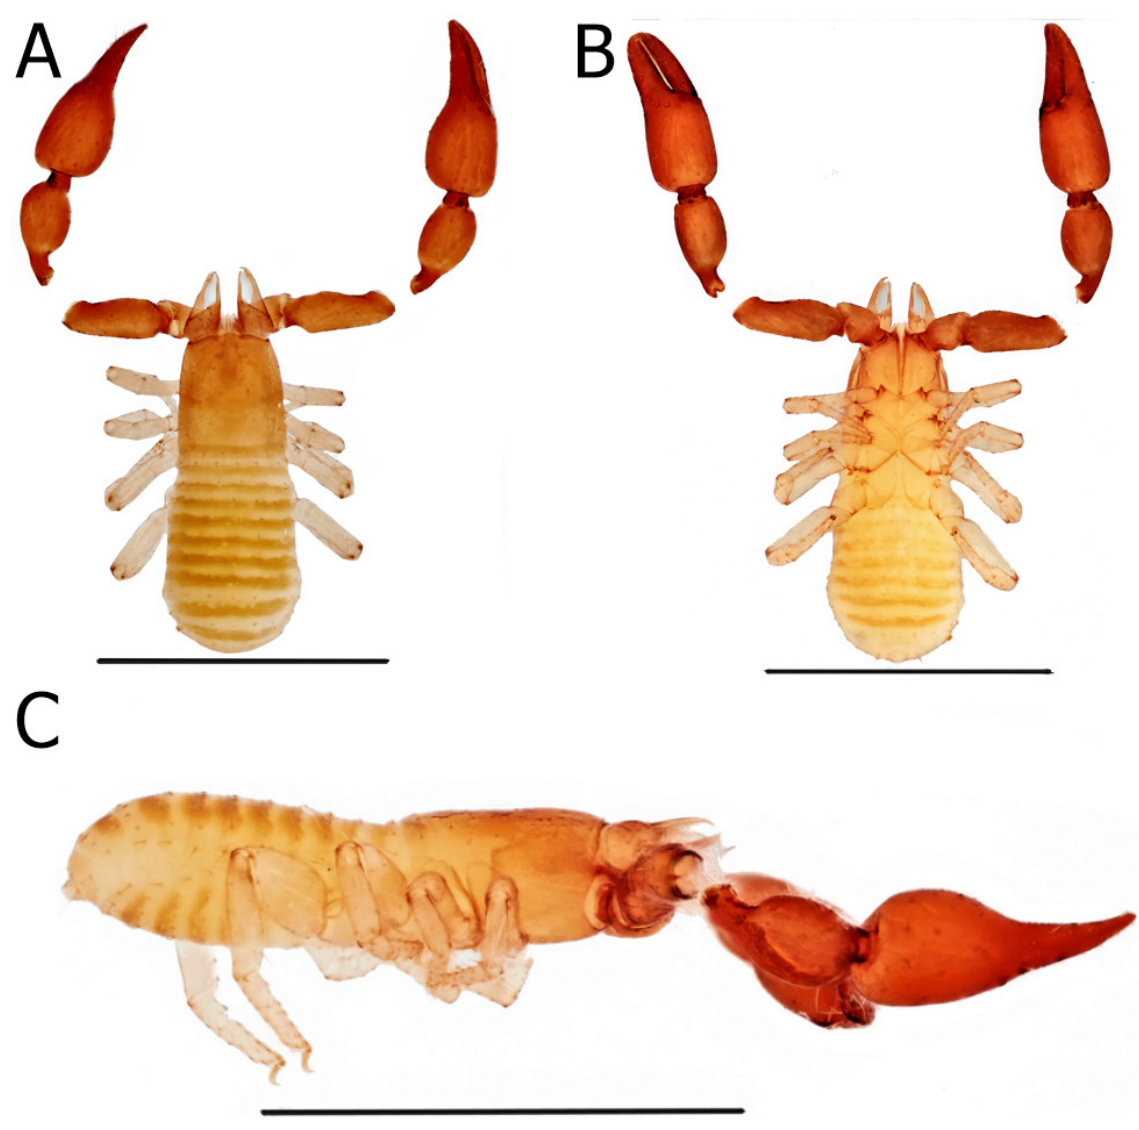
Fig. 20. Ideoblothrus nadineae sp. nov., allotype, ♀ (QCAZ). A . Habitus in dorsal view. B . Habitus in ventral view. C . Habitus in lateral view. Scale bars = 1